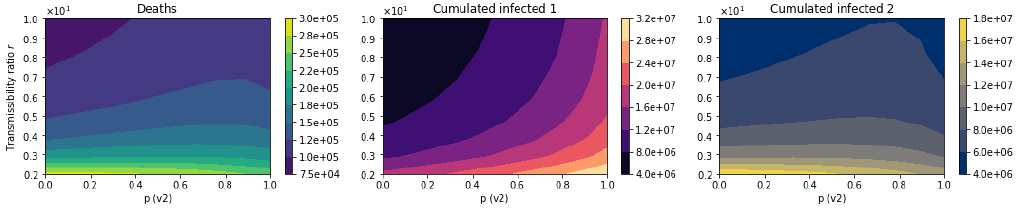
Figure 11. Total number of deaths and the cumulative number of infected people for each age group. This scenario considers a high SARS-CoV-2 transmission rate. The factor that is varied is the transmission rate of 55+ age group.